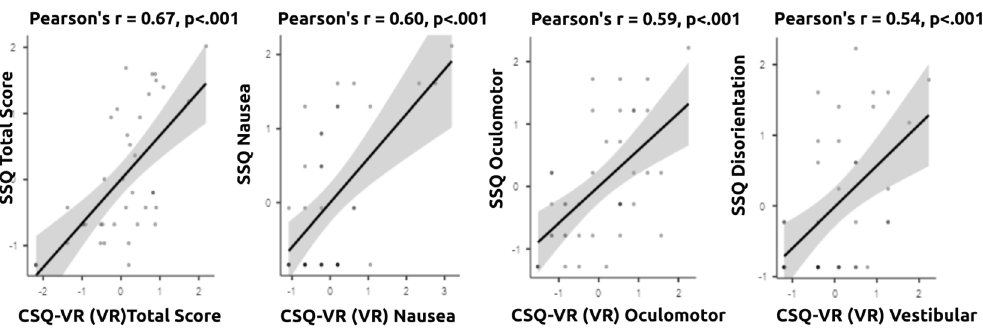
Figure 5. Correlations between the scores of the CSQ-VR (VR version) and the SSQ.